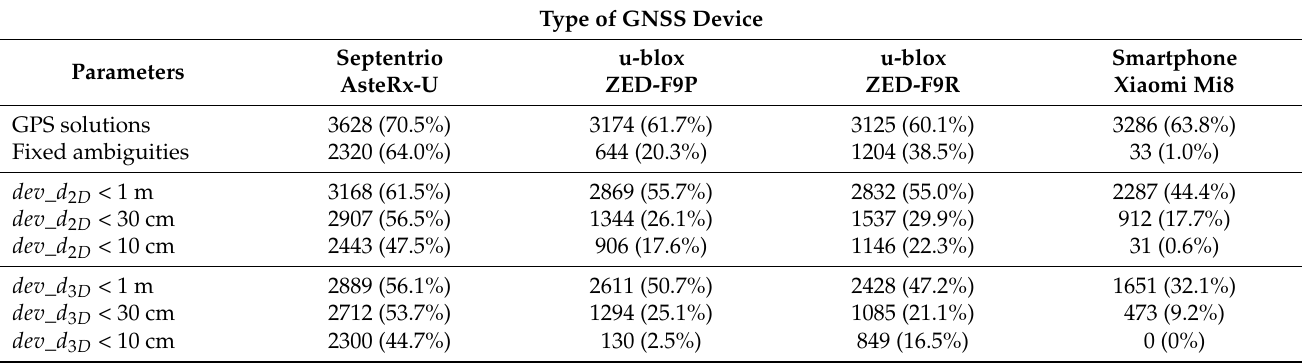
Table 3. GPS solutions, solutions with fixed ambiguities, and deviation of distances below the given threshold. Situation for the entire trajectory: total solutions 5148).